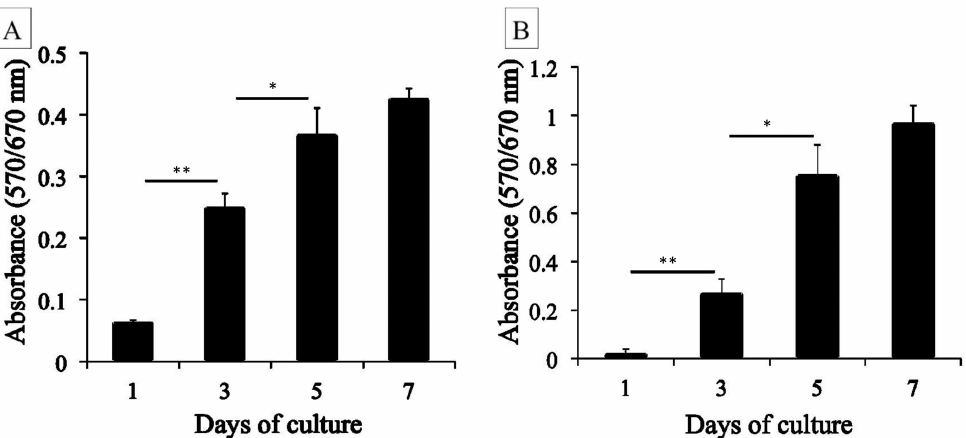
Figure 7. Cell proliferation. Continuous growth of U87-MG cells was reported throughout the culture period, within both sca ff olds: ( A ) Collagen and ( B ) Hyaluronic acid. In particular, proliferation was statistically significant for the first three time points, namely from day 1 to 3 ** ( p = 0.0001 for COL; p = 0.002 for HA); from day 3 to 5 * ( p = 0.0126 for COL; p = 0.035 for HA), whereas no significant di ff erence was observed between the last two time points, corresponding to days 5 and 7. Statistical analysis was performed using t -test multiple comparison with a confidence level of 95% ( p < 0.05). GraphPad was